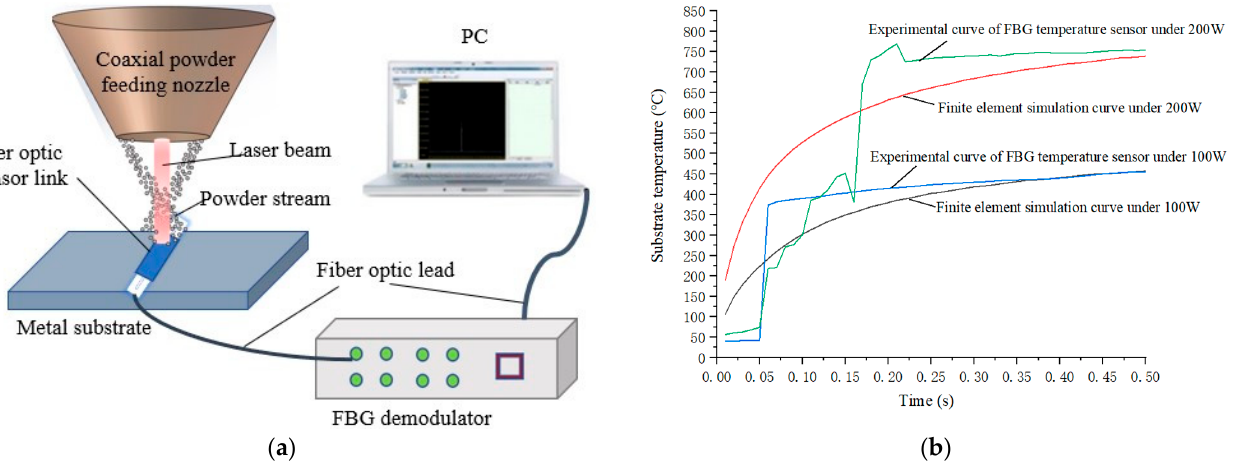
Figure 6. Temperature rise experiment verification diagram: ( a ) FBG sensor verification structure diagram of substrate temperature field, ( b ) Comparison of simulation curve and experimental curve of substrate temperature.